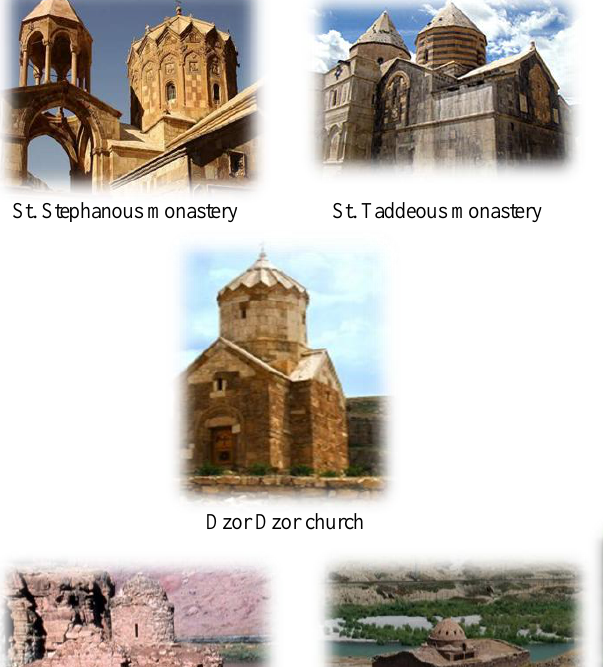
Figure 2. Churches of Armenian Monasteries of